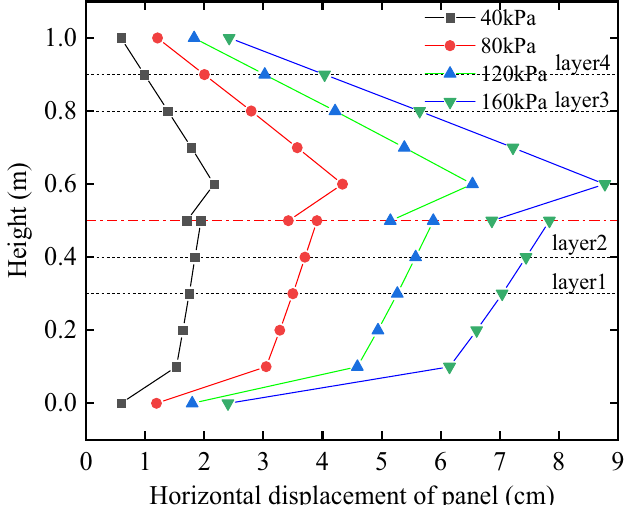
Figure 6: Horizontal displacement of a panel under three working conditions: D2 ( upper - left ) , M2 ( upper - right ) , and U2 ( bottom )